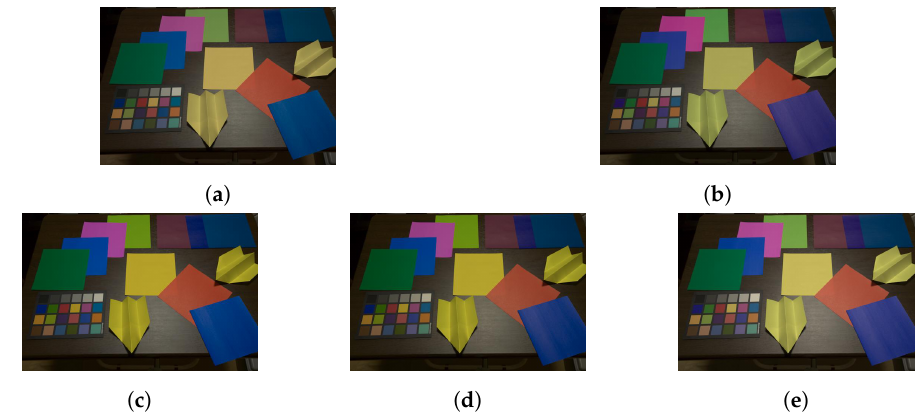
Figure 8. Images adjusted from Figure 7b. ( a ) WB (XYZ), ( b ) WB (von Kries), ( c ) 3CB (6, 9, 14), ( d ) 3CB (11, 14, 24), and ( e ) Cheng (1–24).